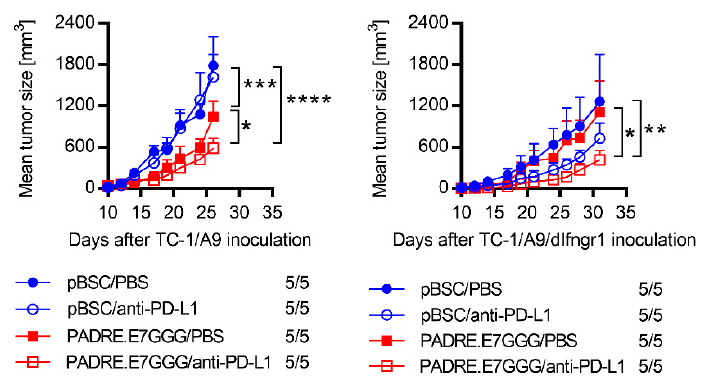
Figure 6. The sensitivity of TC-1 / A9 and TC-1 / A9 / dIfngr1 cells to anti-PD-L1 therapy combined with DNA immunization. Cells (3 × 10 4 ) were s.c. injected to C57BL / 6 mice ( n = 5). Animals were treated with anti-PD-L1 antibody and / or the Pan DR epitope (PADRE).E7GGG DNA vaccine delivered by a gene gun. Control mice received PBS and / or pBSC. The ratio of mice with tumor to the total number of mice in the group is shown. Bars ± SEM; * p < 0.05, ** p < 0.01, *** p < 0.001, **** p < 0.0001.